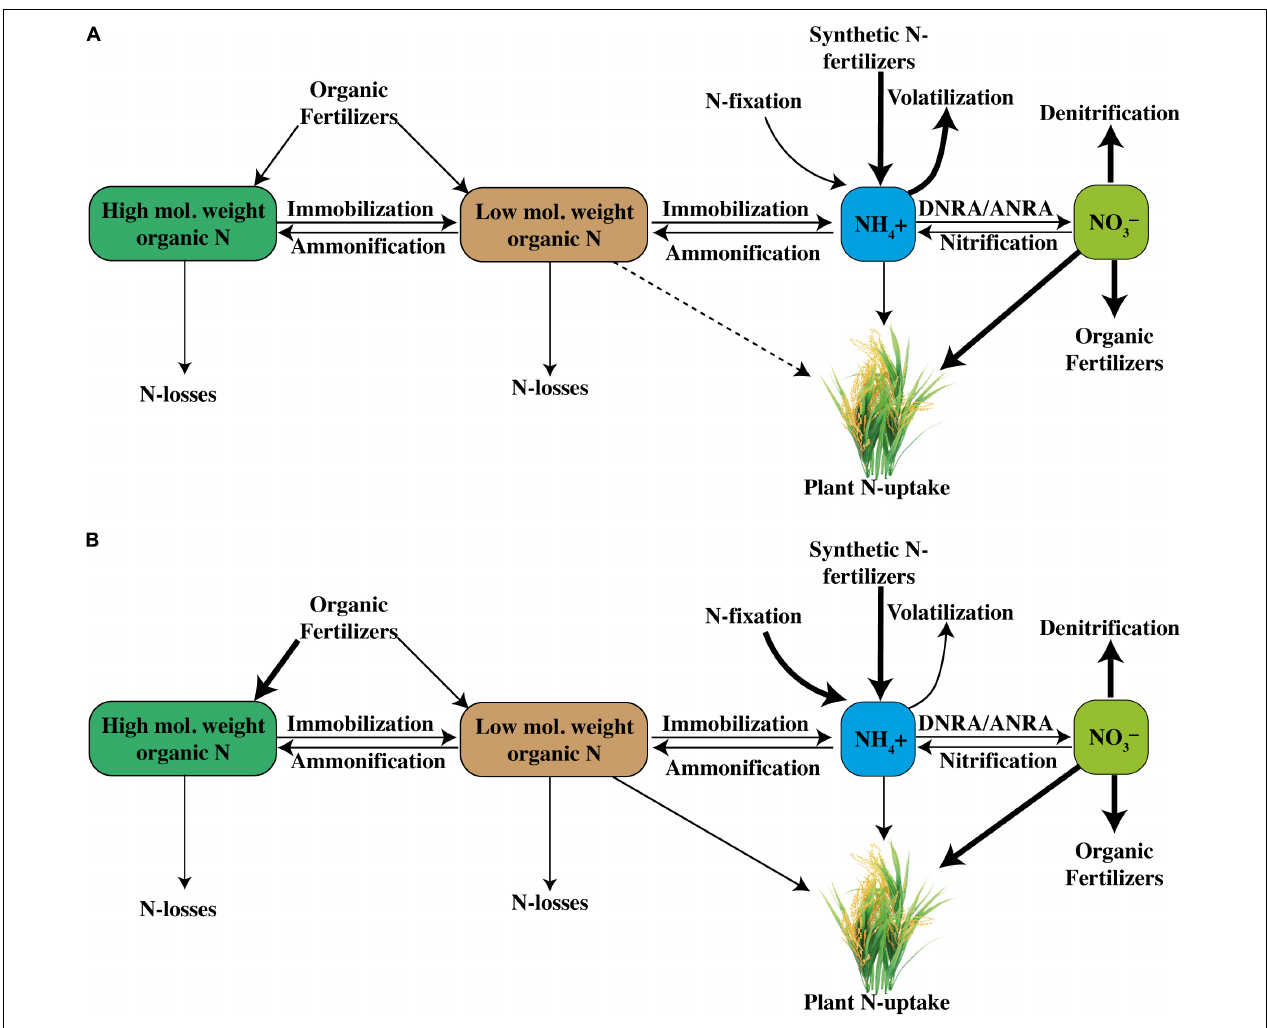
FIGURE 5 | Conjectural comparison of N-cycle under a (A) rice system with higher nitrification rates and a (B) rice system with relatively low nitrification rates (DNRA, dissimilatory NO 3 – reduction to NH 4 + ; and ANRA, assimilatory NO 3 – reduction to NH 4 +